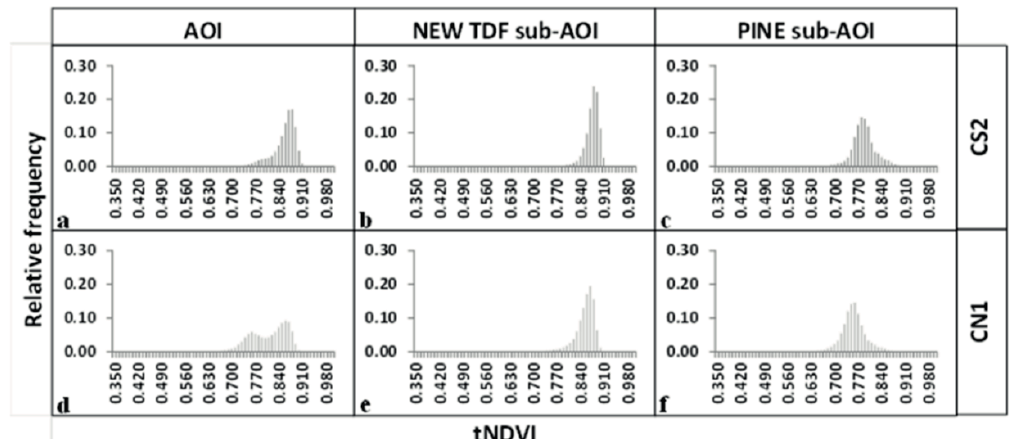
Fig. 4 Examples of tNDVI frequency histograms for CS2 and CN1 AOIs. For the entire AOIs (a) and (d), for NEW TDF (b) and (e) and for the PINE portion (c) and (f). Table 2 Comparison between average tNDVI and nNDVI values for the NEW TDF sub-AOIs and the corresponding average salinity. AOI